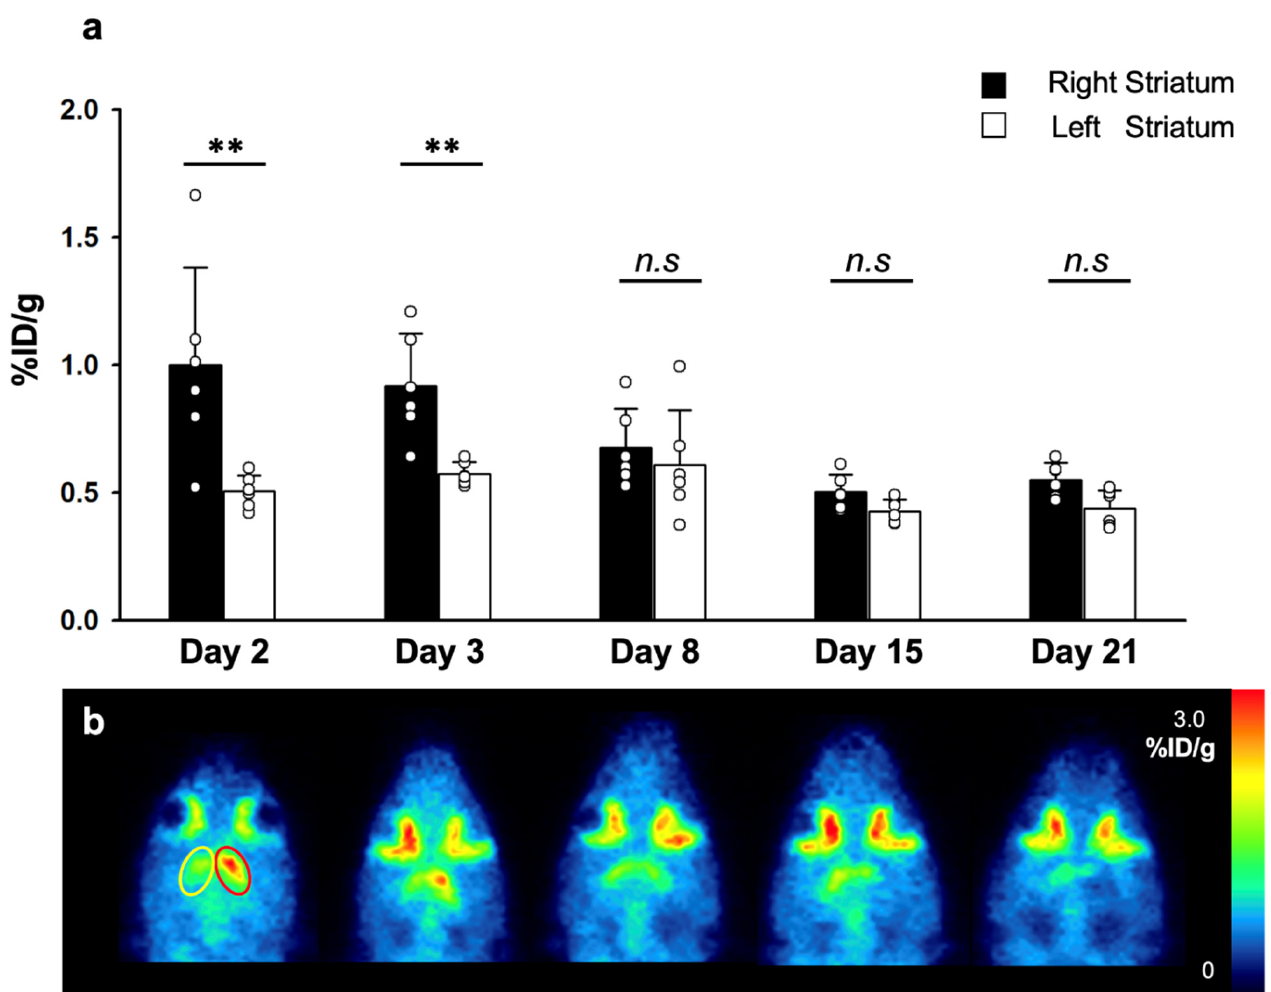
Figure 4. %ID/g values of 3-[ 18 F]F-CP118,954 ( 1 ) on days 2, 3, 8, 15 and 21 after MCAO surgery ( a ). Representative 3-[ 18 F]F-CP118,954 ( 1 ) PET images at respective days ( b ). Red oval indicates the MCAO-lesioned VOI, and yellow oval indicates the contralateral VOI. The statistical significance of differences were determined using the Mann-Whitney U test; ** p < 0.01. n.s. : not significant.